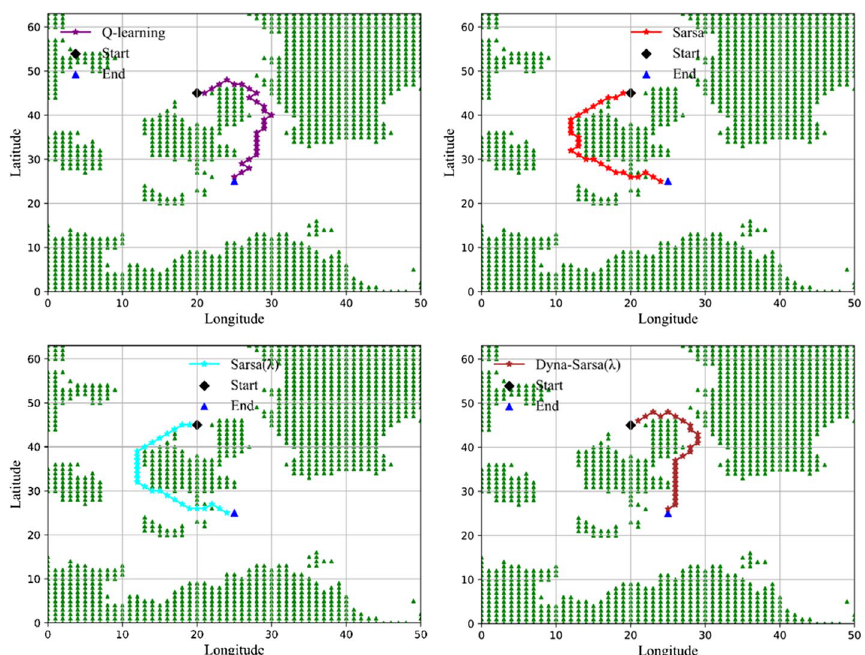
Fig. 11 Path planning simulation of four types of learning model. The visualization results of path planning simulation achieved by the proposed model and